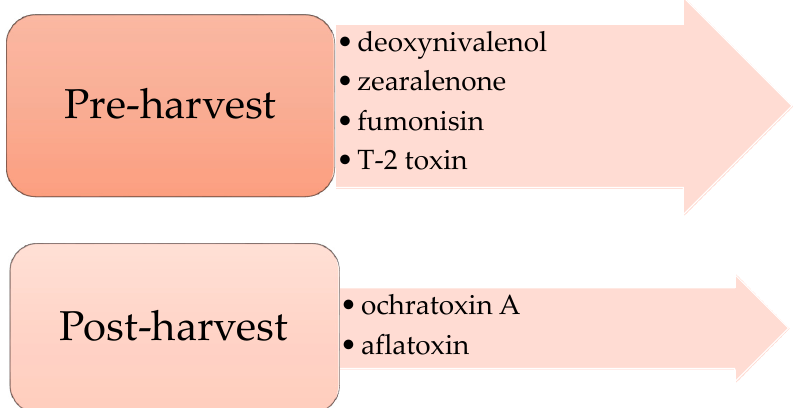
Figure 2. Mycotoxins that most often contaminate cereals pre ‐ harvest and post ‐ harvest. Based on [32,33].